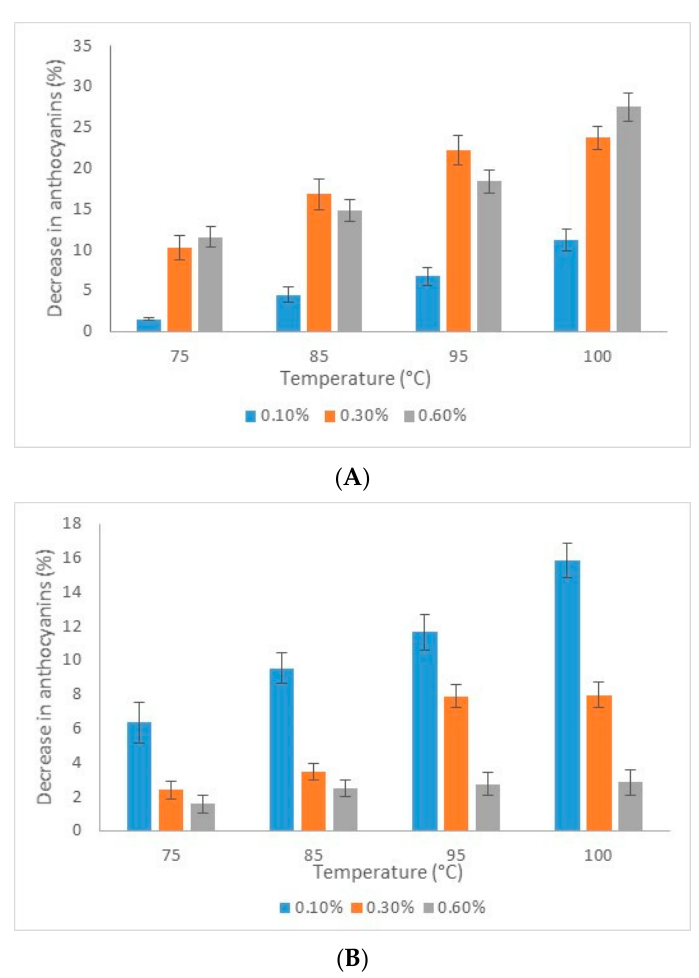
Figure 5. Evolution of the total anthocyanins content decrease in microcapsules obtained after thermal treatment at different temperatures varying between 75 and 100 °C for 15 min at different concentrations: ( A ) variant 1 and ( B ) variant 2.